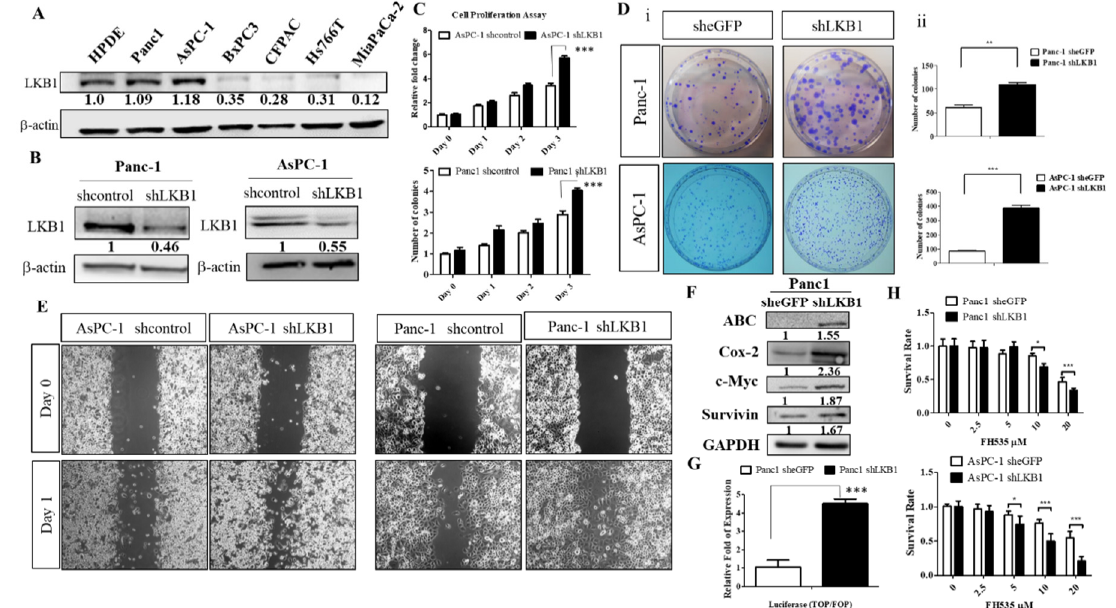
Figure 6. Knockdown of LKB1 promotes cell proliferation and migration/invasion and induces the Wnt/ β -catenin signaling pathway in human pancreatic ductal adenocarcinoma (PDAC) cells. ( A ). Western blot analysis of LKB1 protein expression in normal human pancreatic duct epithelial (HPDE) and different human PDAC cell lines. Relative protein expression based on densitometry are listed below the images. ( B ). Western blotting analysis revealed the knockdown efficiency of LKB1 in Panc-1 and AsPC-1 human PDAC cells. The level of knockdown was quantified by densitometric analysis of Western blots using ImageJ software. ( C ). The MTT (thiazolyl blue tetrazolium bromide) cell proliferation assay showed that the knockdown of LKB1 promotes the human PDAC cell proliferation rate in vitro. *** p < 0.001. ( D ). ( i ) The sphere formation assay determined that the knockdown of LKB1 significantly increases colony formation in human PDAC cells. ( ii ) Quantitation of cell colony numbers of Panc-1 shLKB1, AsPC-1 shLKB1 and their sheGFP control cells. *** p < 0.001. ( E ). Knockdown of LKB1 in human Panc-1 and AsPC-1 PDAC cells increases cell motility by using an in vitro wound healing assay. ( F ). Western blotting indicated that LKB1 knockdown in human PDAC cells leads to upregulation of the levels of ABC, Cox-2, c-MYC, and survivin proteins served as downstream effectors of the Wnt pathway. Relative densitometric values are provided below the blot images. ( G ). Luciferase assay showing the increased TOP/FOP luciferase reporter activity in Panc-1 shLKB1 cells, compared with Panc-1 sheGFP control cells. *** p < 0.001. ( H ). MTT cell survival assays showed that FH535 significantly reduced cell proliferation rates in Panc-1 shLKB1, AsPC-1shLKB1, and eGFP control cells. * p < 0.01; *** p < 0.001.